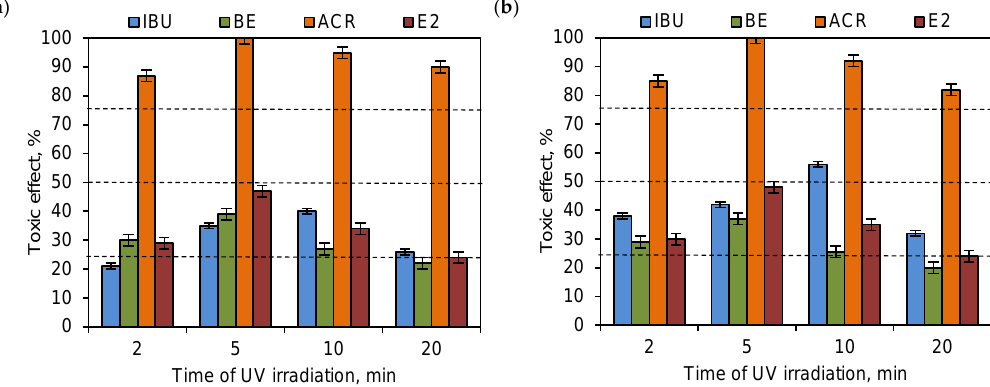
Figure 12. Change in the toxicity of the tested ( a ) deionized water and ( b ) surface water solution after the UV/NaOCl/O 3 process (dashed lines indicate the boundaries between the toxicity classes).